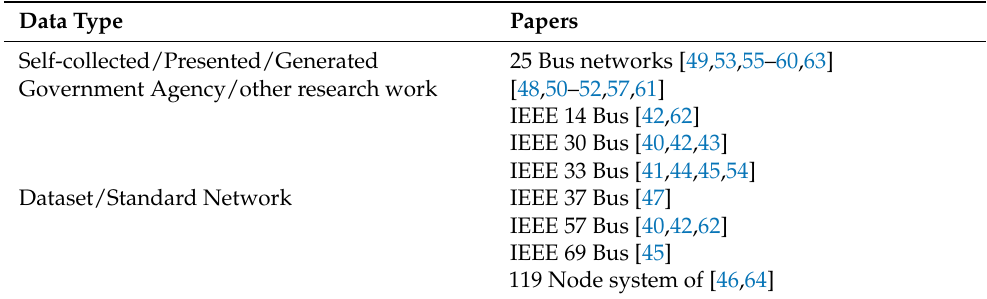
Table 6. Data setup used for Smart Grid.